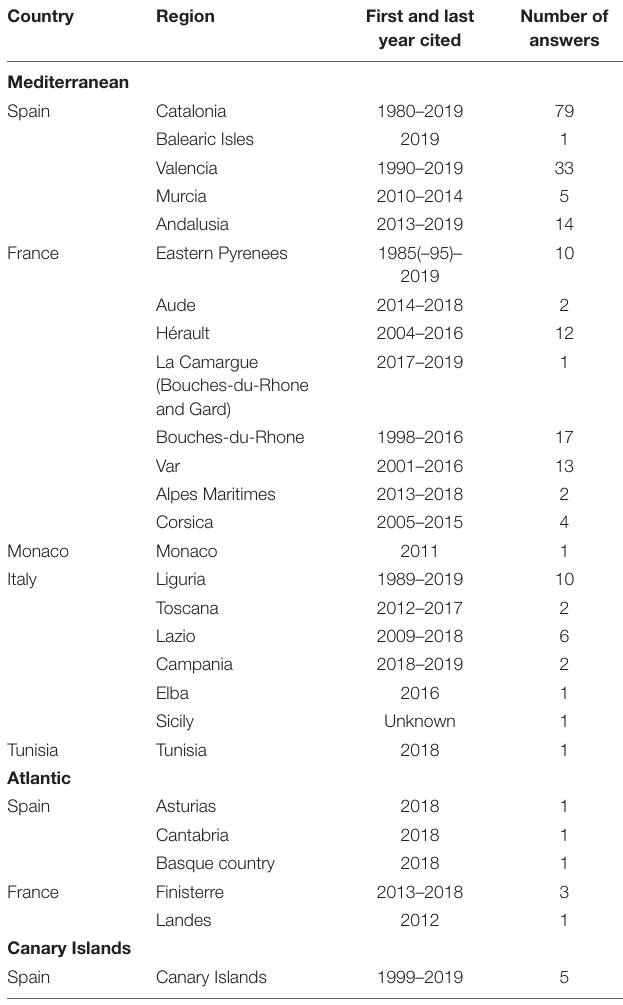
TABLE 1 | Summary of the regions grouped by country and marine area where fishers reported they captured anomalous white seabream, and years of the oldest and most recent report.